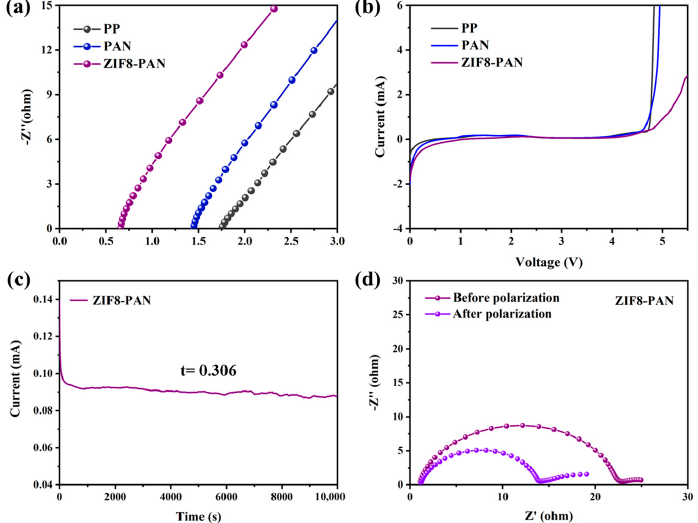
Figure 4. Electrochemical characterization of the cells assembled with three different separators at 25 °C. ( a ) Electrochemical impedance spectra for SS//SS cells. ( b ) LSV of SS//Li cells. ( c ) Chronoamperometry profile and ( d ) Nyquist plot before and after polarization for symmetric battery assembled with ZIF8-PAN separator.